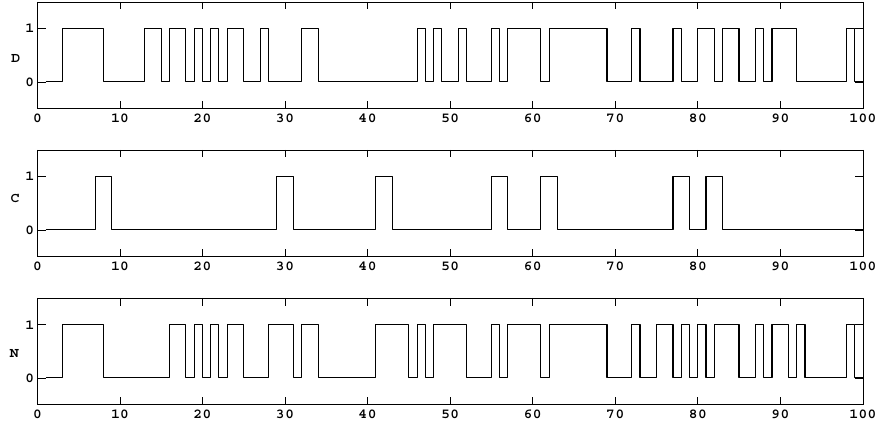
Figure 9. Sequences { D i } , { C j } and { N k } obtained from the Lorenz system and logistic map with µ = 3.99. The first 100 bits are shown from each sequence of 5000